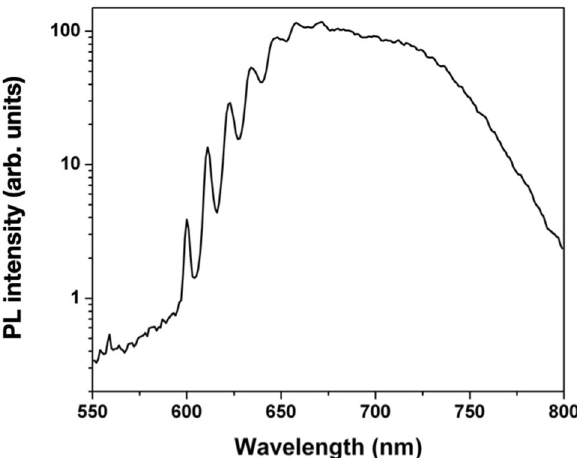
Figure 3. PL spectrum acquired at 4.5 K temperature under 488 nm laser excitation from the region of sample #1 implanted with at 5 × 10 13 cm −2 fluence.